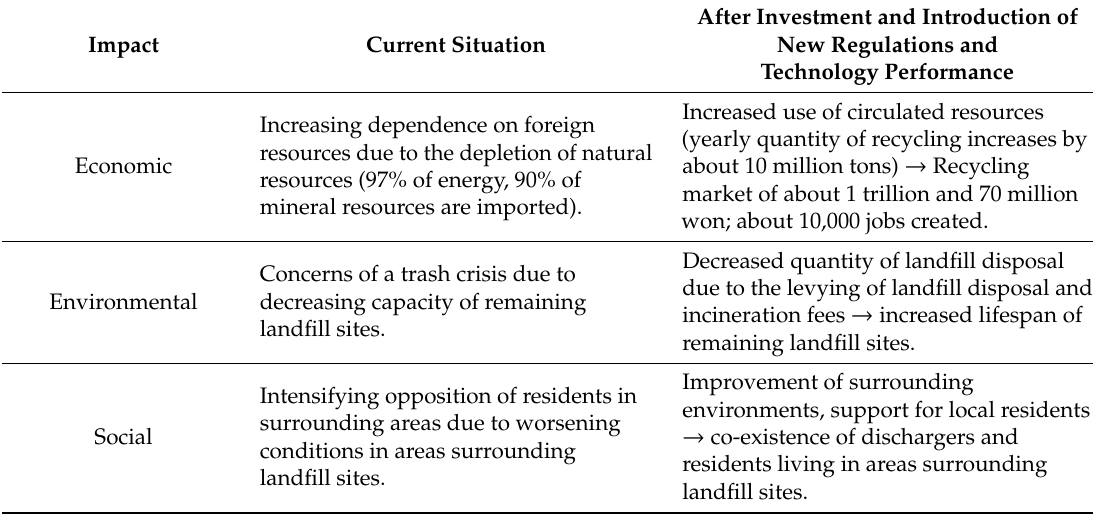
Table 6. Expected results from investment activities in Korean waste management